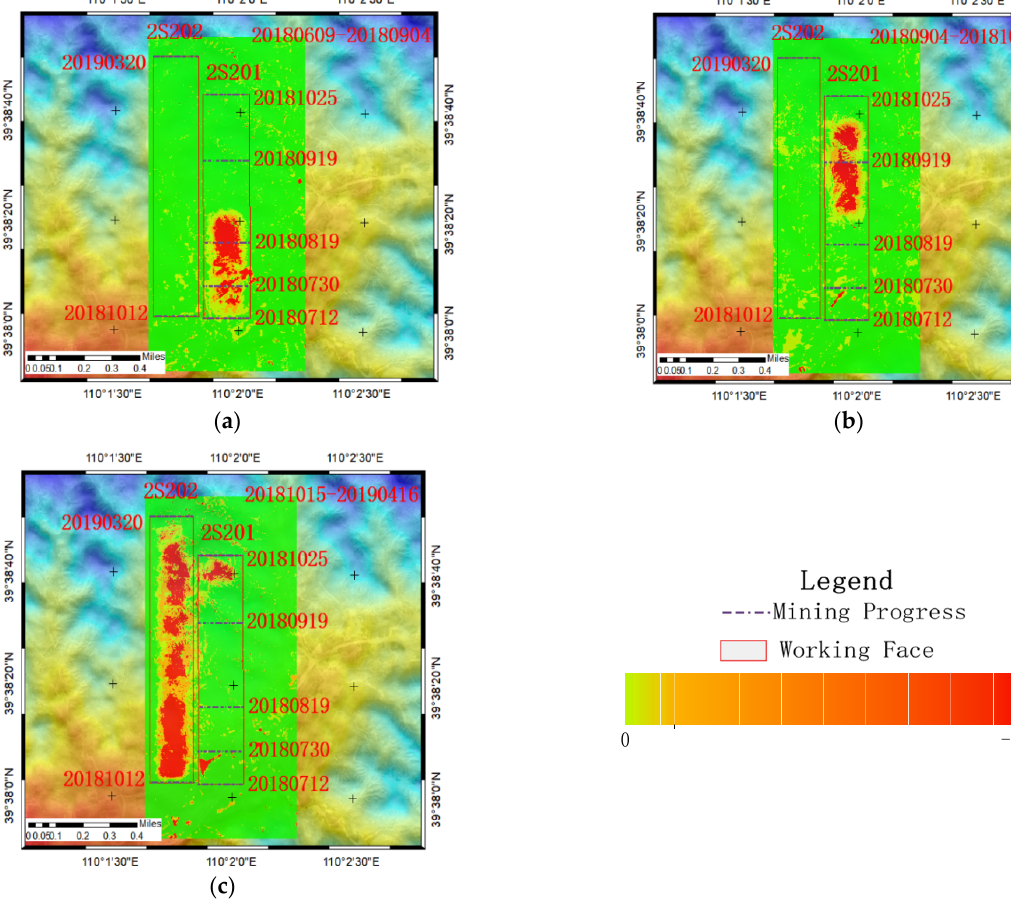
Figure 8. ( a – c ) are respectively the settlement maps of UAV time series; 2S201 and 2S202 are working faces; the data is of production.